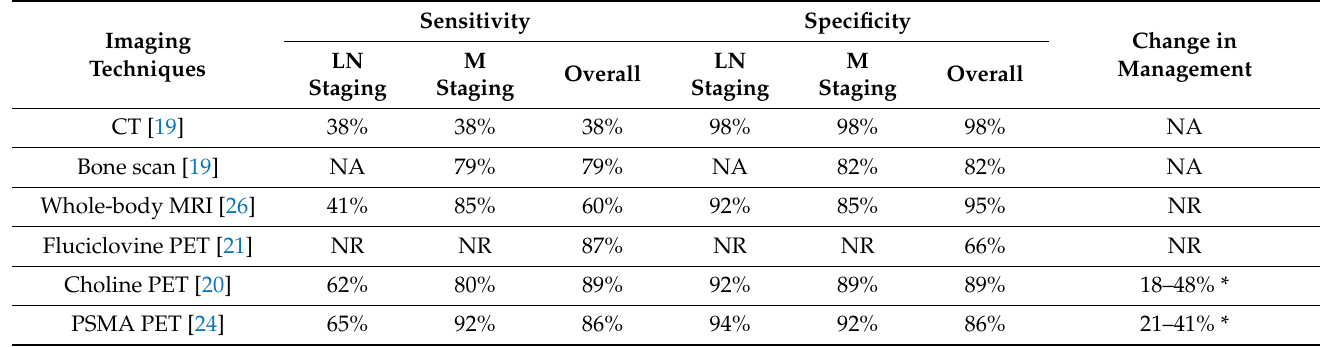
Table 1. Sensitivity and specificity of imaging techniques in the diagnosis of oligometastatic prostate